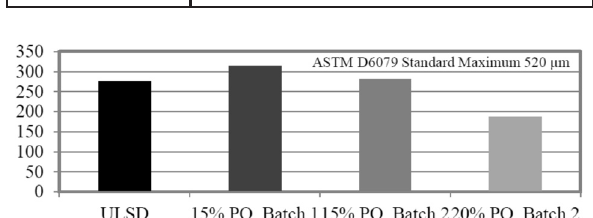
Fig. 15. Corrected Wear Scar Diameter